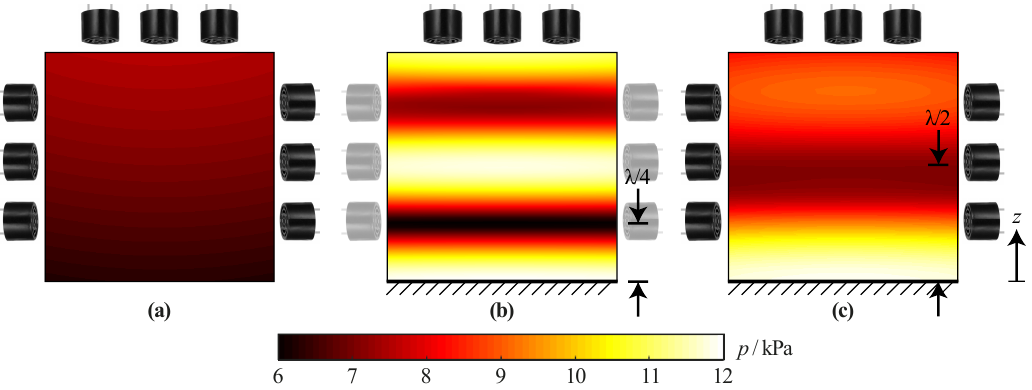
Figure 5. Distribution of the maximum attainable pressure (DMAP) for ( a ) a single-sided array in free space, ( b ) the top part of the single-sided array with an acoustically reflective surface ( R = 1) at z = 0 exhibiting high gradients that prohibit the generation of arbitrary focal points, and ( c ) the single-sided arrangement with an acoustically reflective surface at z = 0 with a gradient that allows manipulation at z ≥ λ